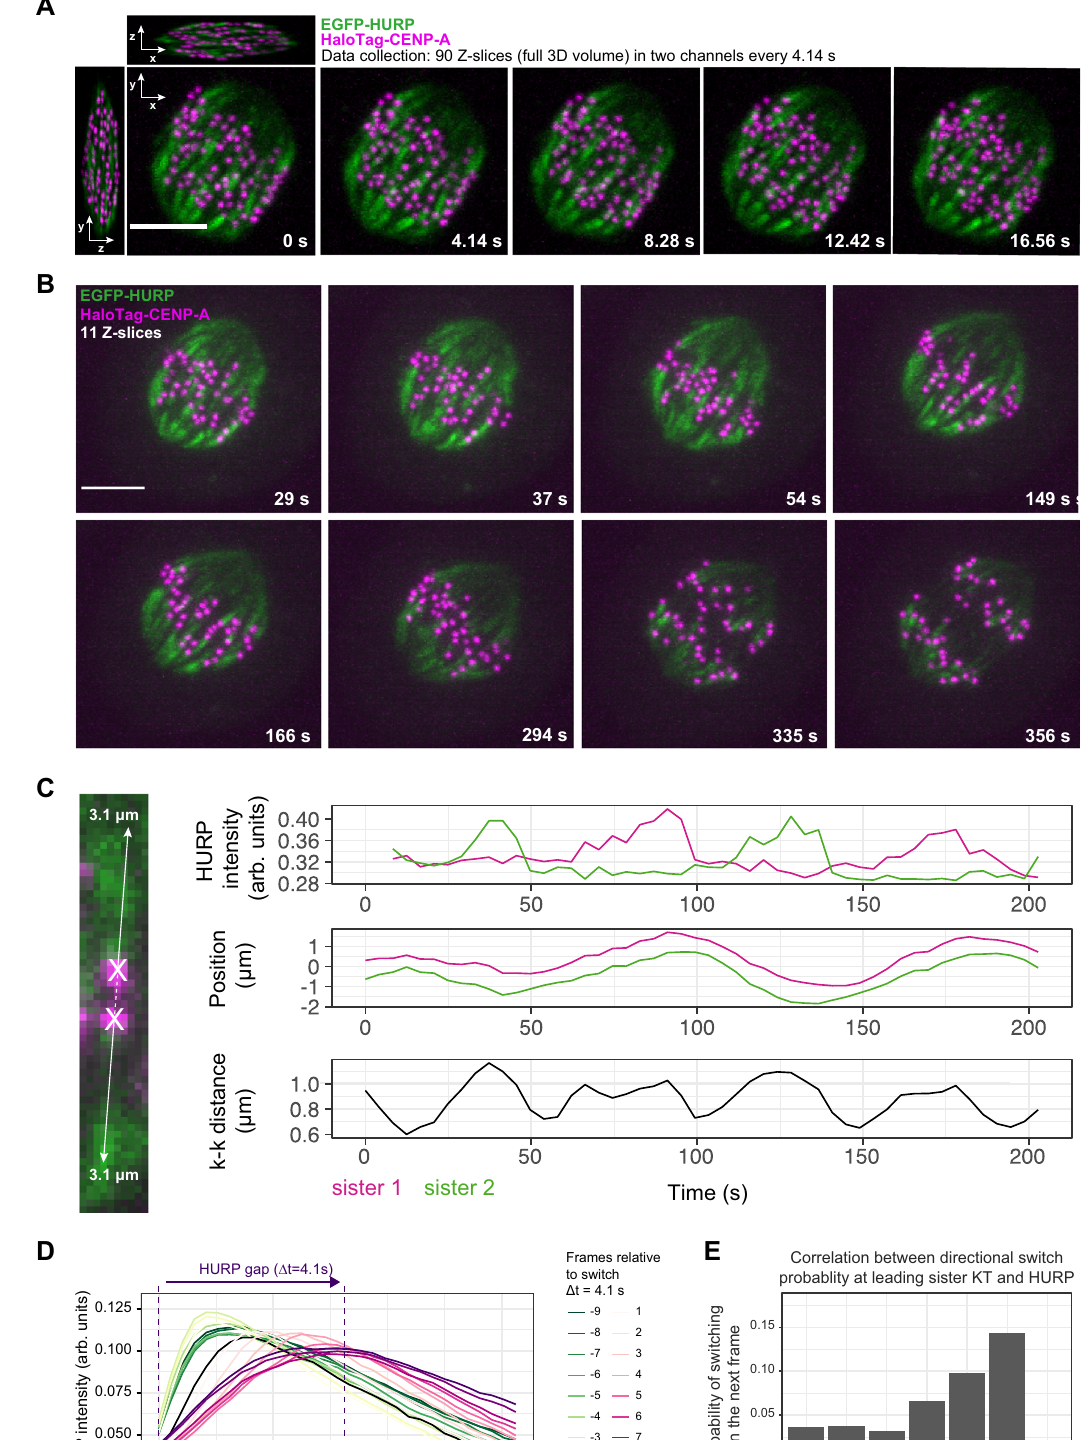
Fig. 2 | HURP-gaps are precisely linked to K- fi bre growth state. A Lattice light- sheet 3D representation (X-, Y- and Z-projections) of a metaphase hTERT-RPE1- EGFP-HURP/HaloTag-CENP-A cell and relative movie stills projected in Z (90 z- slices). Scale bar=5 µ m. B Lattice light-sheet movie stills of the same cell in A projected in Z (11 z-slices). Scale bar=5 µ m. C Exemplary HURP intensities and